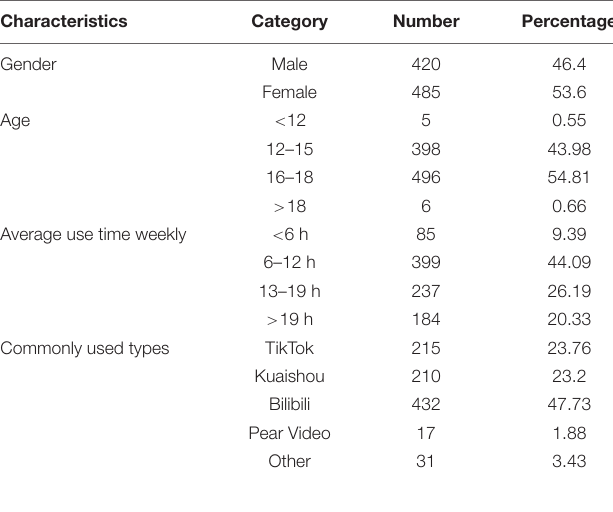
TABLE 1 | Survey participants (cid:48) descriptive